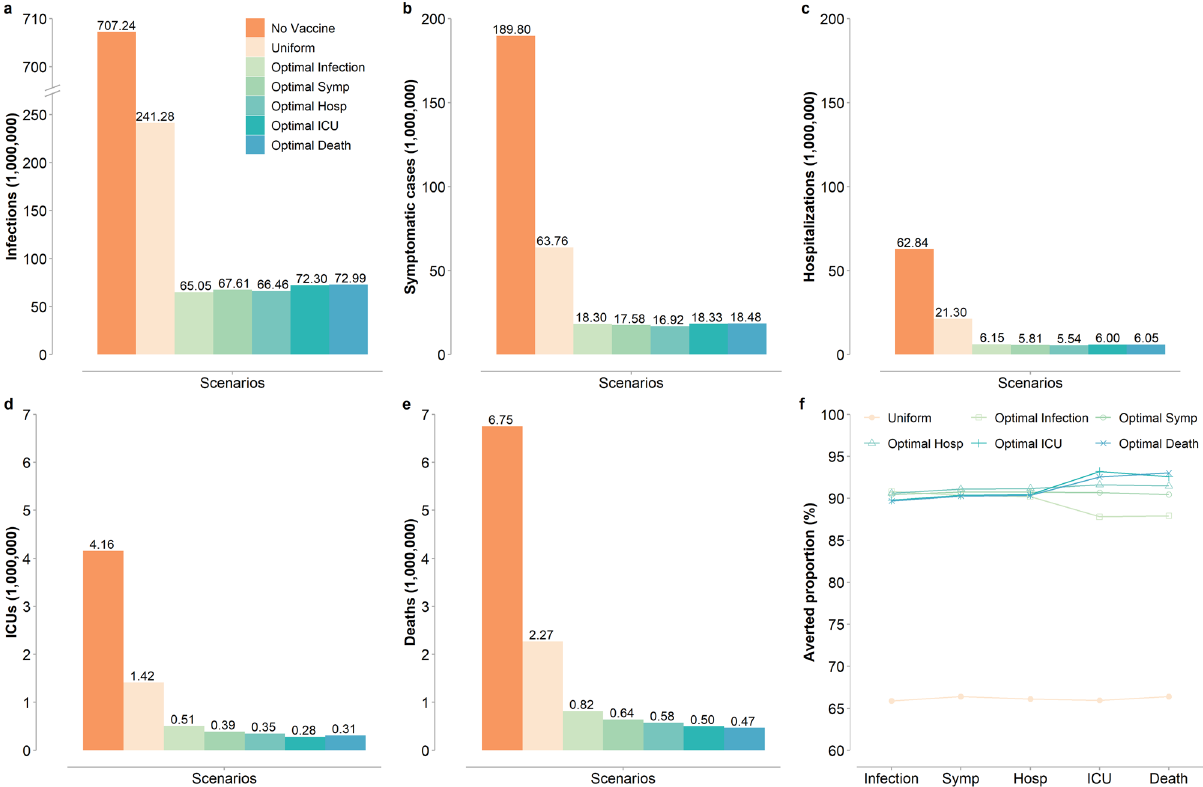
Fig. 2 Risk incidences for different prioritization strategies and the scenario with no vaccination (0.14% rollout speed, R = 1.5). a Number of infections under the scenario with no vaccination, uniform vaccination strategy, and the fi ve optimal prioritization strategies we identi fi ed. b – e As ( a ), but for the number of symptomatic cases, hospitalizations, ICUs, and deaths, respectively. f Averted proportion of infections, symptomatic cases, hospitalizations, ICUs, and deaths for the six vaccination strategies as compared to the scenario with no vaccination. Keys in a apply to ( a – e ). “ Optimal Symp ” and “ Optimal Hosp ” represent the two optimal strategies for minimizing symptomatic cases and hospitalizations